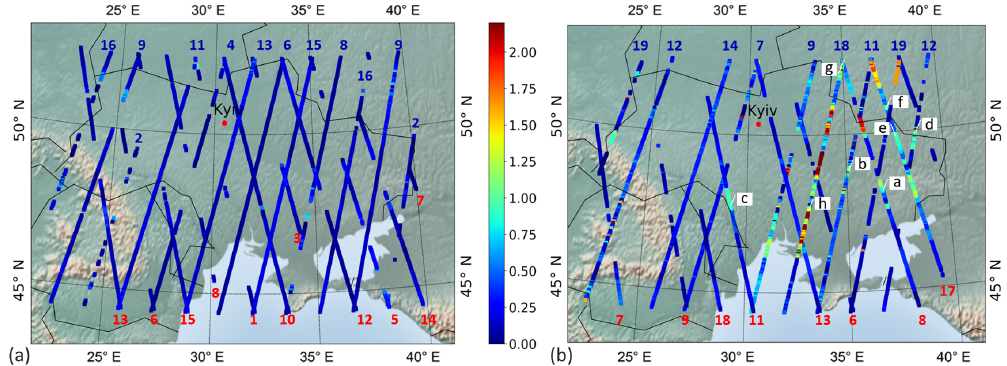
Figure 8. AOD 532nm distribution over Ukraine from CALIOP measurements during 16-day periods from 1 to 16 June (a) and from 4 to 19 August (b) 2010. Red numbers at the bottom of the map indicate dates of each daytime track running to northwest and blue numbers at the top of the map indicate the date of each nocturnal track running to southwest. Labels a–h in Fig. 8b indicate the location of profiles, which are further analyzed and shown in Fig.